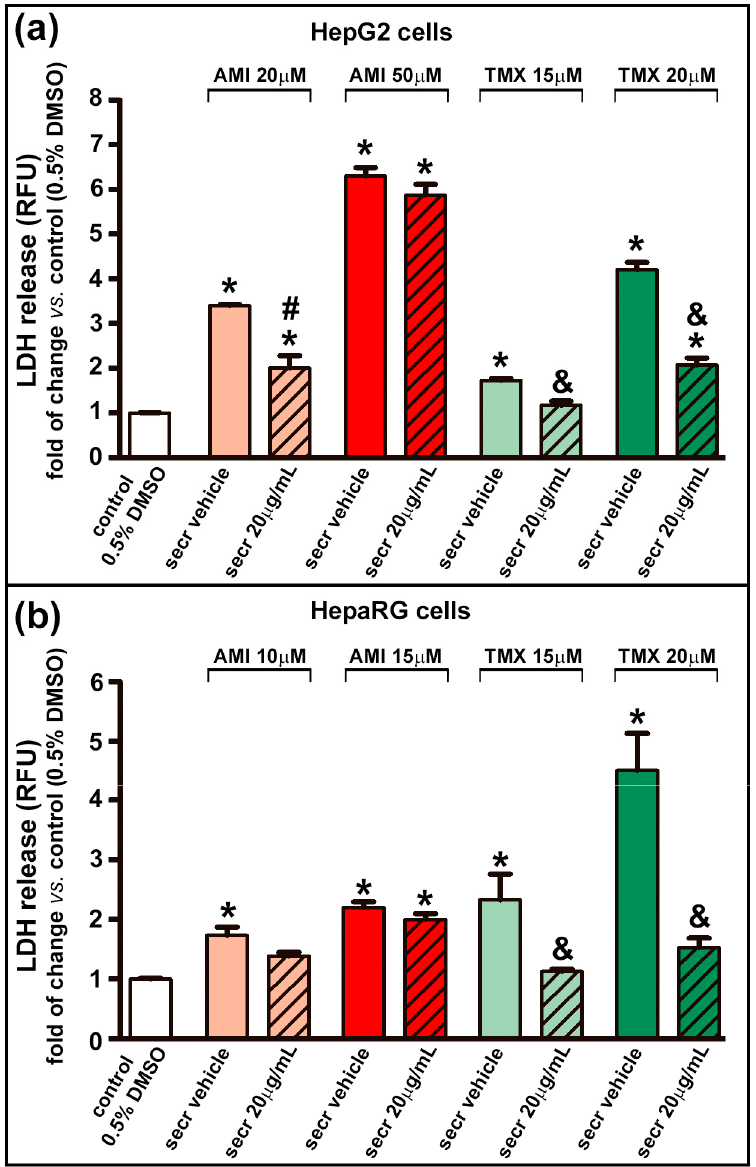
Figure 2. MSC secretome decreased the release of LDH in hepatic cells incubated with TMX. The integrity of the plasma membrane was evaluated by the release of LDH into the culture medium in ( a ) HepG2 and ( b ) HepaRG cells exposed to AMI (light and dark red bars) or TMX (light and dark green bars) alone or coincubated with MSC secretome (20 µg/mL—line pattern bars), or the secretome vehicle (PBS) for 24 h. As a control group, cells were incubated with the drug solvent (0.5% DMSO—white bars). The amount of LDH released in the culture medium was determined by a fluorescent method (shown as relative fluorescence units), and expressed as fold of change vs. control group (0.5% DMSO). A dose-dependent release of LDH was observed in both cell lines when exposed to AMI or TMX. While a moderate effect was seen in HepG2 cells treated with 20 µ M AMI plus secretome. Data are presented as means ± SEM ( n = 4) of three independent experiments. * p < 0.05 vs. control group (0.5% DMSO); # p < 0.05 vs. AMI plus secretome vehicle, of the same experimental group (same AMI concentration); & p < 0.05 vs. TMX plus secretome vehicle, of the same experimental group (same TMX concentration). secr vehicle: MSC secretome vehicle (PBS); secr: MSC secretome; AMI: amiodarone; TMX: tamoxifen. LDH: lactate dehydrogenase. RFU: relative fluorescence